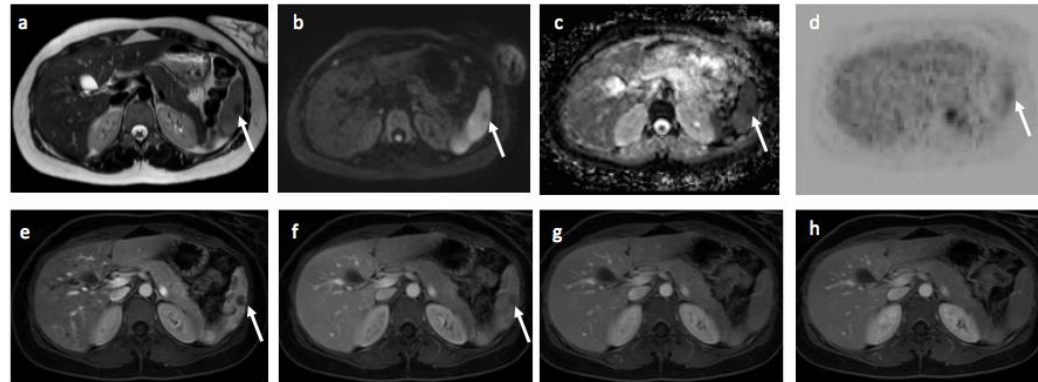
Figure 3. Images of a 24-year-old female patient with Hodgkin’s lymphoma highlighting extra-nodal perceptual error on 18 F-FDG PET-CT. Splenic involvement was considered positive on WB-MRI and negative on 18 F-FDG PET-CT. Following the consensus review, the panel corrected the disease site to be positive on 18 F-FDG PET-CT and subsequently, the enhanced reference standard was positive for splenic involvement. ( a ) T2-TSE, ( b ) DWI b 1000 , ( c ) ADC map, ( d ) 18 F-FDG PET, ( e ) DCE spleen: early-arterial phase, ( f ) DCE spleen: mid- arterial phase, ( g , h ) DCE spleen: late-arterial phase. Arrows showing a focal lesion in spleen.